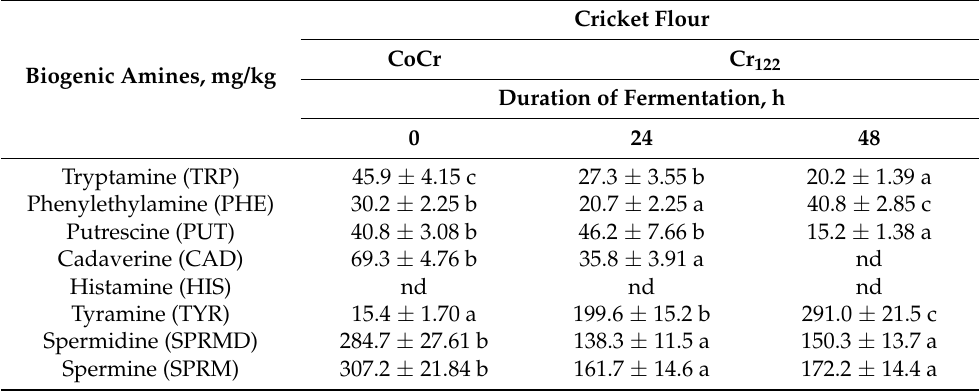
Table 3. Biogenic amine (BA) concentration (mg/kg) in non-treated and fermented cricket flours.